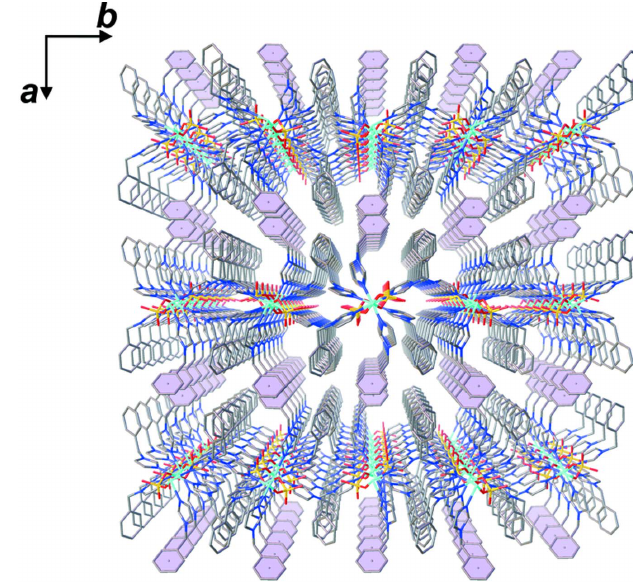
Figure 4 View of interchain (cid:3) – (cid:3) interactions in the title compound along the a axis. [Symmetry code: (v) (cid:5) x , (cid:5) y + 1, (cid:5) z + 1].